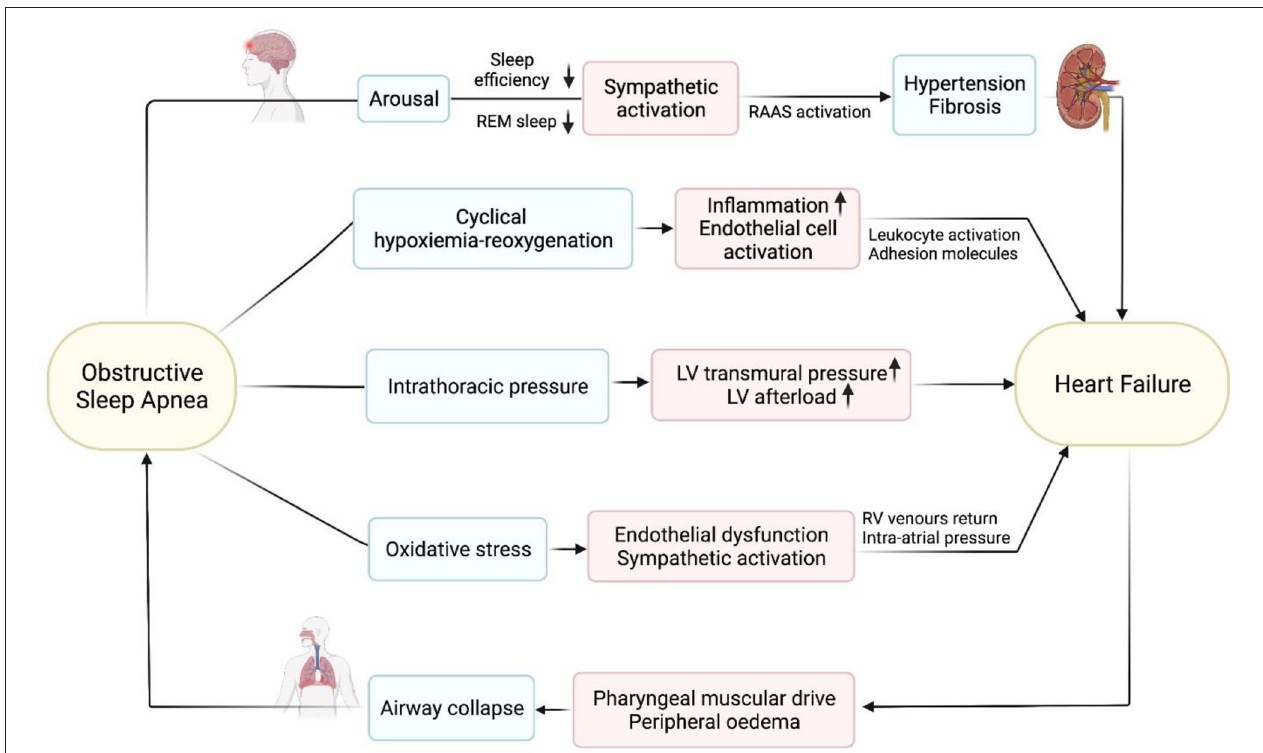
FIGURE 1 | The pathogenesis of OSA in heart